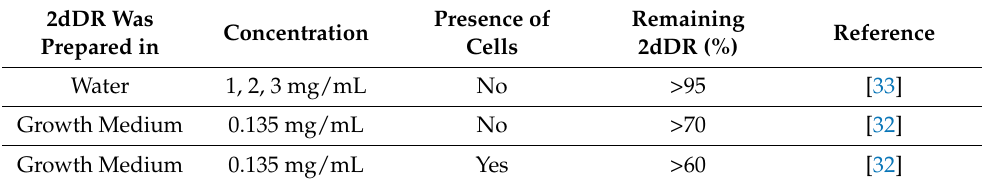
Table 1. Summary of 2dDR stability